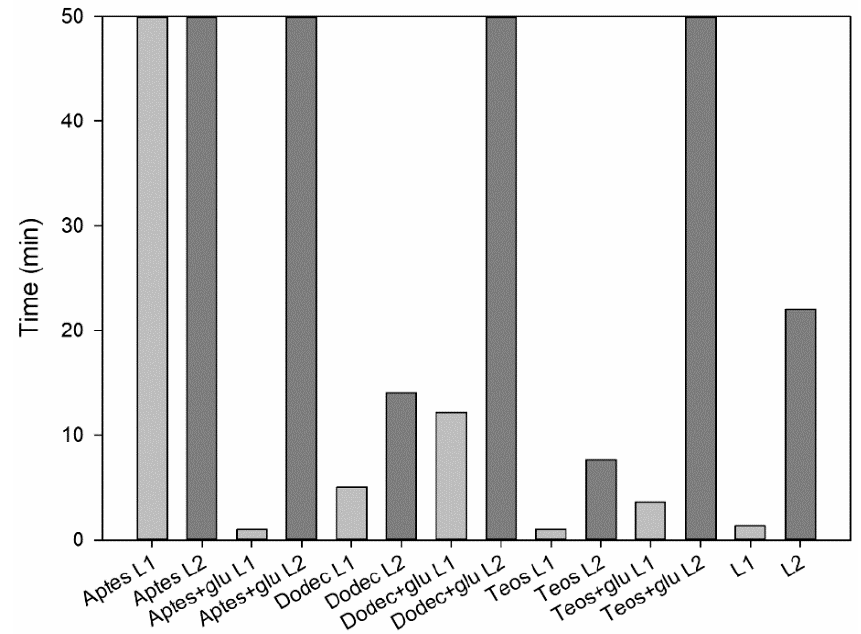
Figure 6. Filtration and retention of water by the adsorbents.